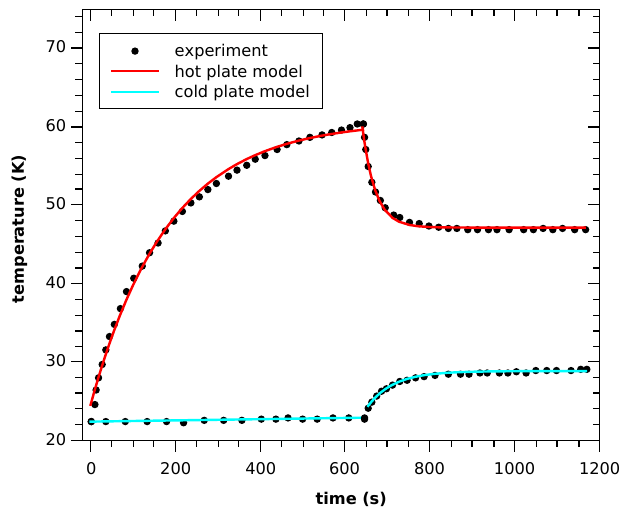
Figure 7. Time evolution of the hot and cold plate temperatures of the thermal switch based on the nanofluid from Ref. [22], and respective modeled curves with the proposed analytical